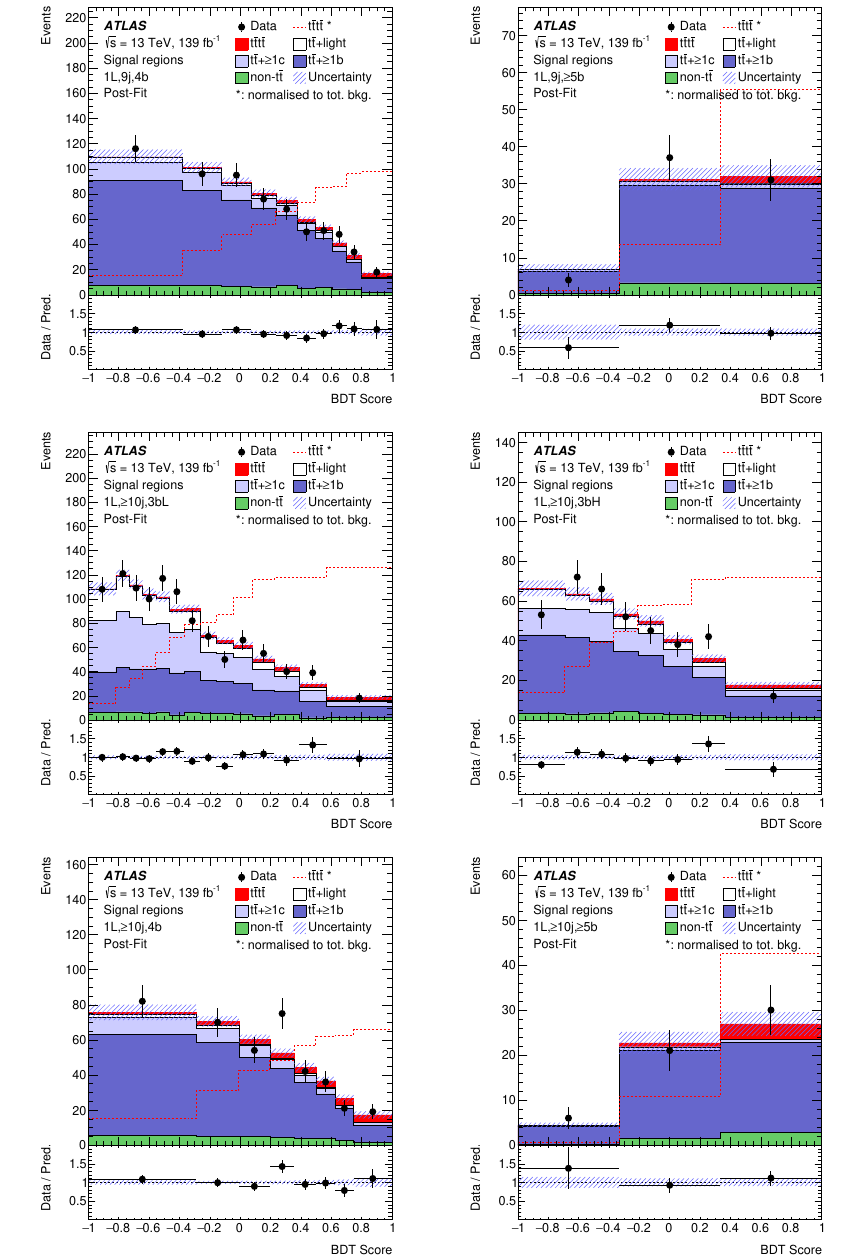
Figure 7 . Comparison between data and post-fit prediction for the distributions of the BDT score in each signal region in the 1L channel. The band includes the total uncertainty of the post-fit computation. The dashed red line shows the signal distribution normalised to the background yield. The ratio of the data to the total post-fit computation is shown in the lower